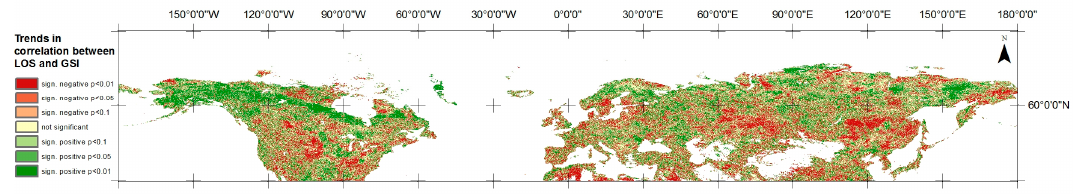
Figure 7. Trends in correlations between LOS and GSI from 1982–1997 to 1998–2013 (17 moving windows).